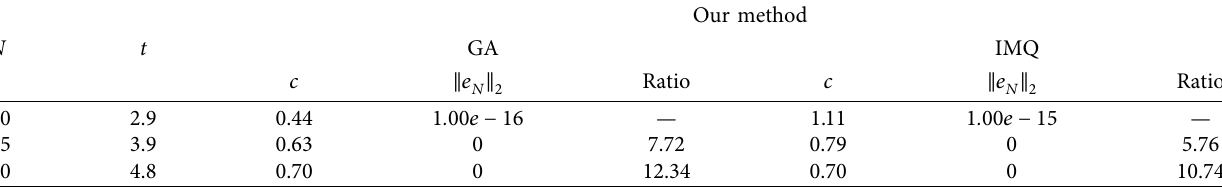
Figure 7: The absolute error function graph by using the proposed method for Example 2 with different values of N . Table 3: The absolute errors of the numerical solutions by using the proposed method for Example 2.